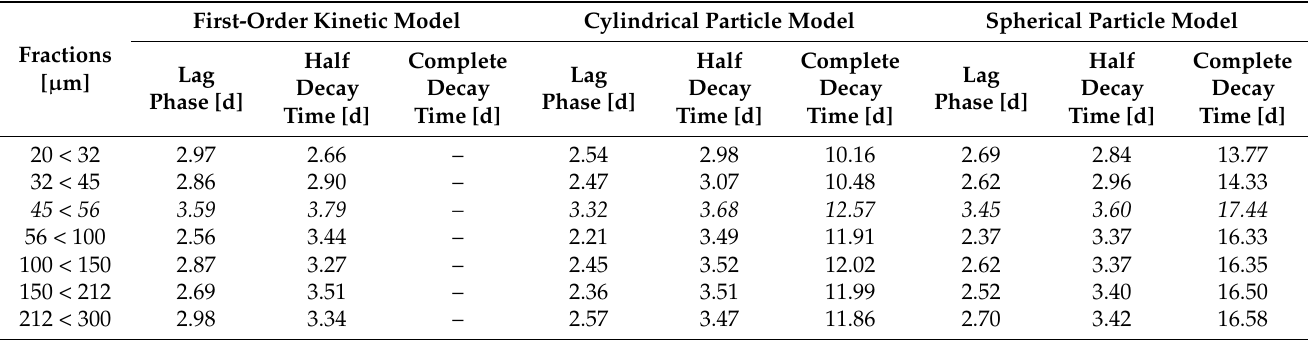
Table 4. Comparison of lag-phase duration, half decay time, and complete decay time. Complete decay time compared for surface related models